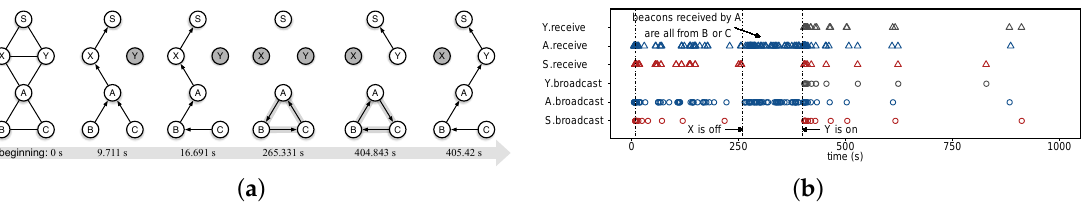
Figure 5. Snapshots and beaconing of the CTP’s operation in experiment T-III, during which node X is shut down at the 260th second and node Y is turned on at the 400th second. The dynamics of link l YS in T-III is the same as that of link l YS in T-II. In the beaconing plot, for the clarity, we only show randomly-sampled 20% of the points between the 260th and the 400th seconds for two kinds of beaconing events, “A.broadcast” and “A.receive”. ( a ) critical snapshots; ( b ) route